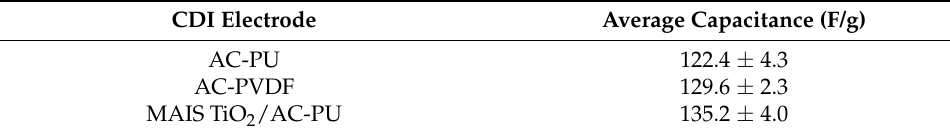
Figure 2. Cyclic voltammetry (CV) plots of different electrodes in 0.5 M NaCl aqueous electrolyte at a scan rate of 10 mV/s. Table 2. The average capacitance of the different electrodes 1 .